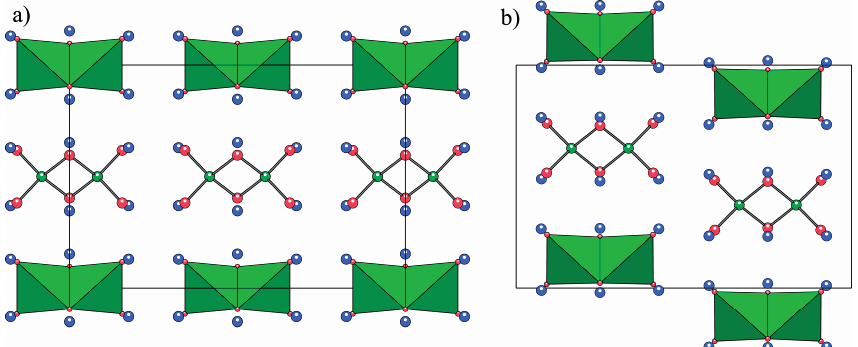
Figure 1. ( a ) Combined ball-and-stick and polyhedral representation of the crystal structure of Ba 3 AlSb 3 (space group Cmce ) and ( b ) Ba 3 GaSb 3 (space group Pnma ), viewed down the direction of the b- and c -axis, respectively. The blue circles represent the Ba atoms, the green circles are the Al or Ga atoms, and the red circles are the Sb atoms. The unit cells are outlined by solid black